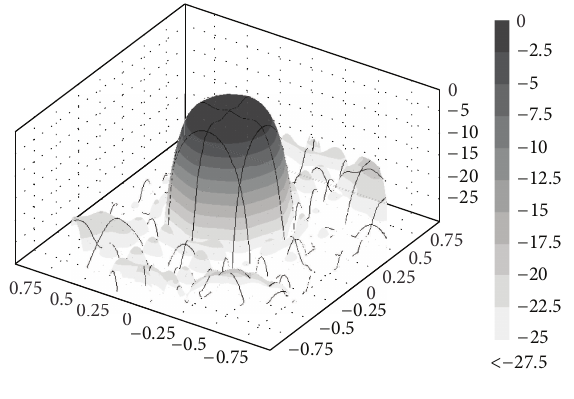
Figure 8: Differences between the required and designed radiation pattern (both in dB scale) for the 8 × 8 planar array with a circular radiation pattern in the u - v